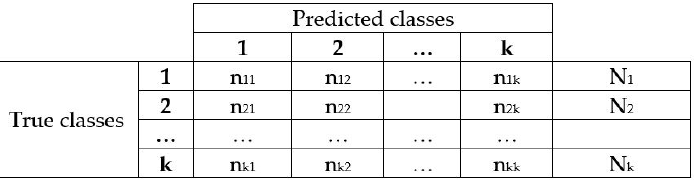
Figure 2. Confusion matrix for k